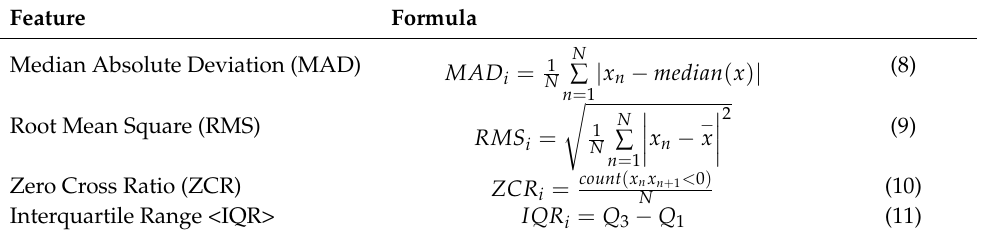
Table 2. Statistical